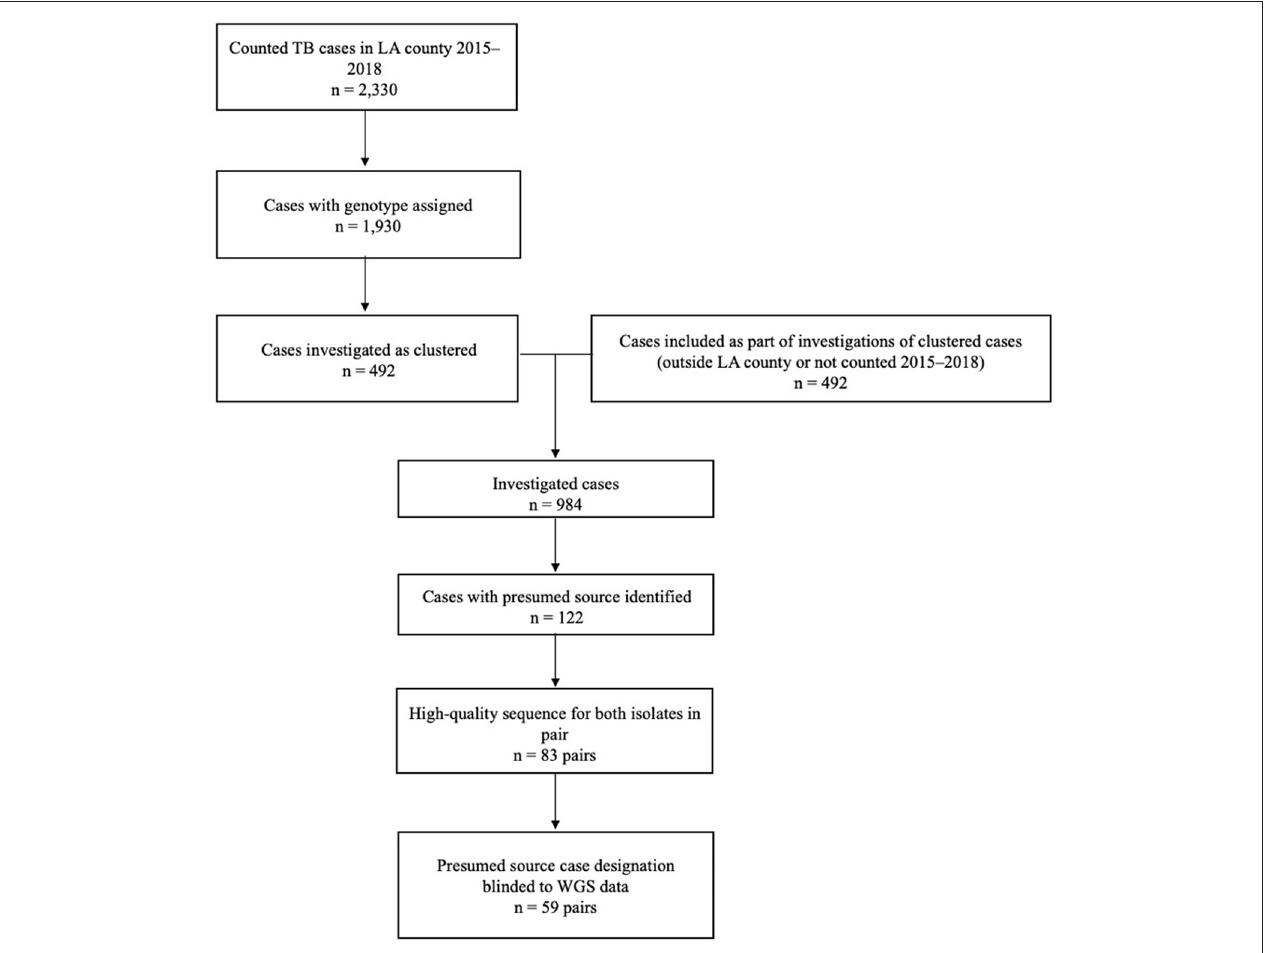
FIGURE 3 | Inclusion criteria for the analytic data set of genotype-matched TB source–secondary case pairs in Los Angeles (LA) County, California, 2015–2018 a . a Genotype-matched clusters are defined on the basis of a combination of spacer oligonucleotide typing (spoligotyping) and 24-locus mycobacterial